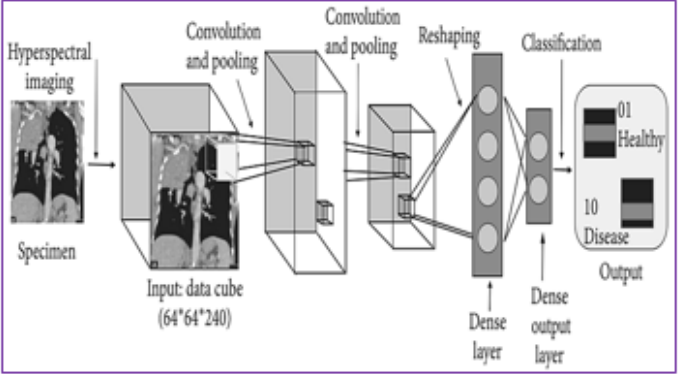
Figure 3. Model of 3D CNN for effective classification [19].